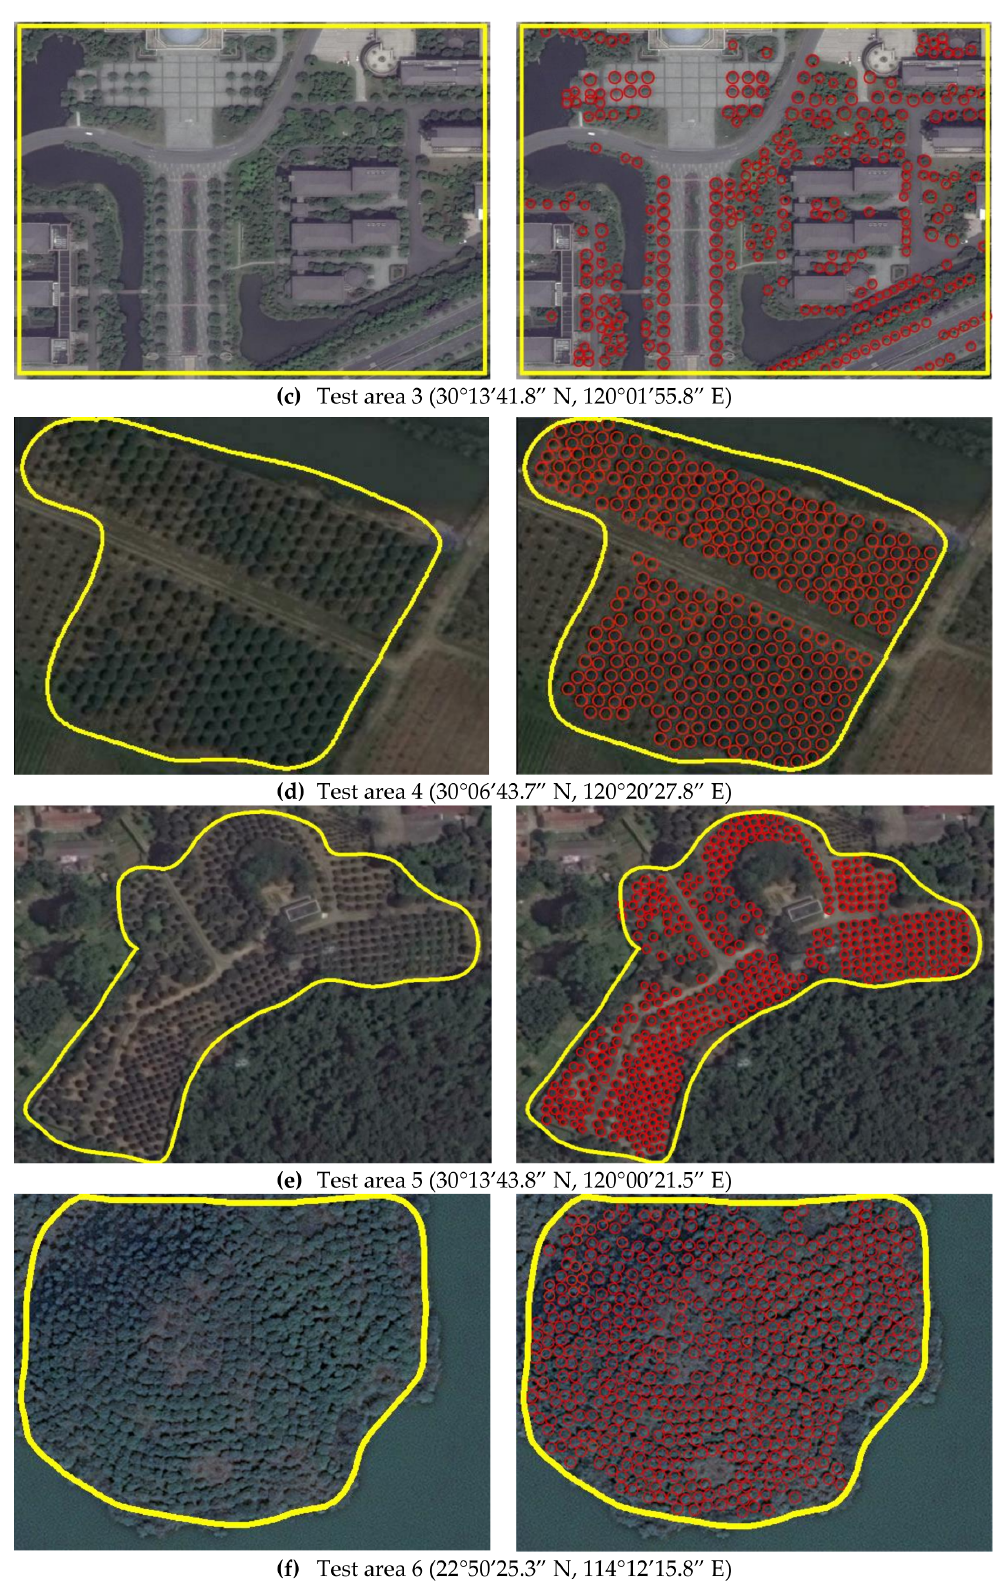
Figure 1. Six different test areas and the corresponding reference